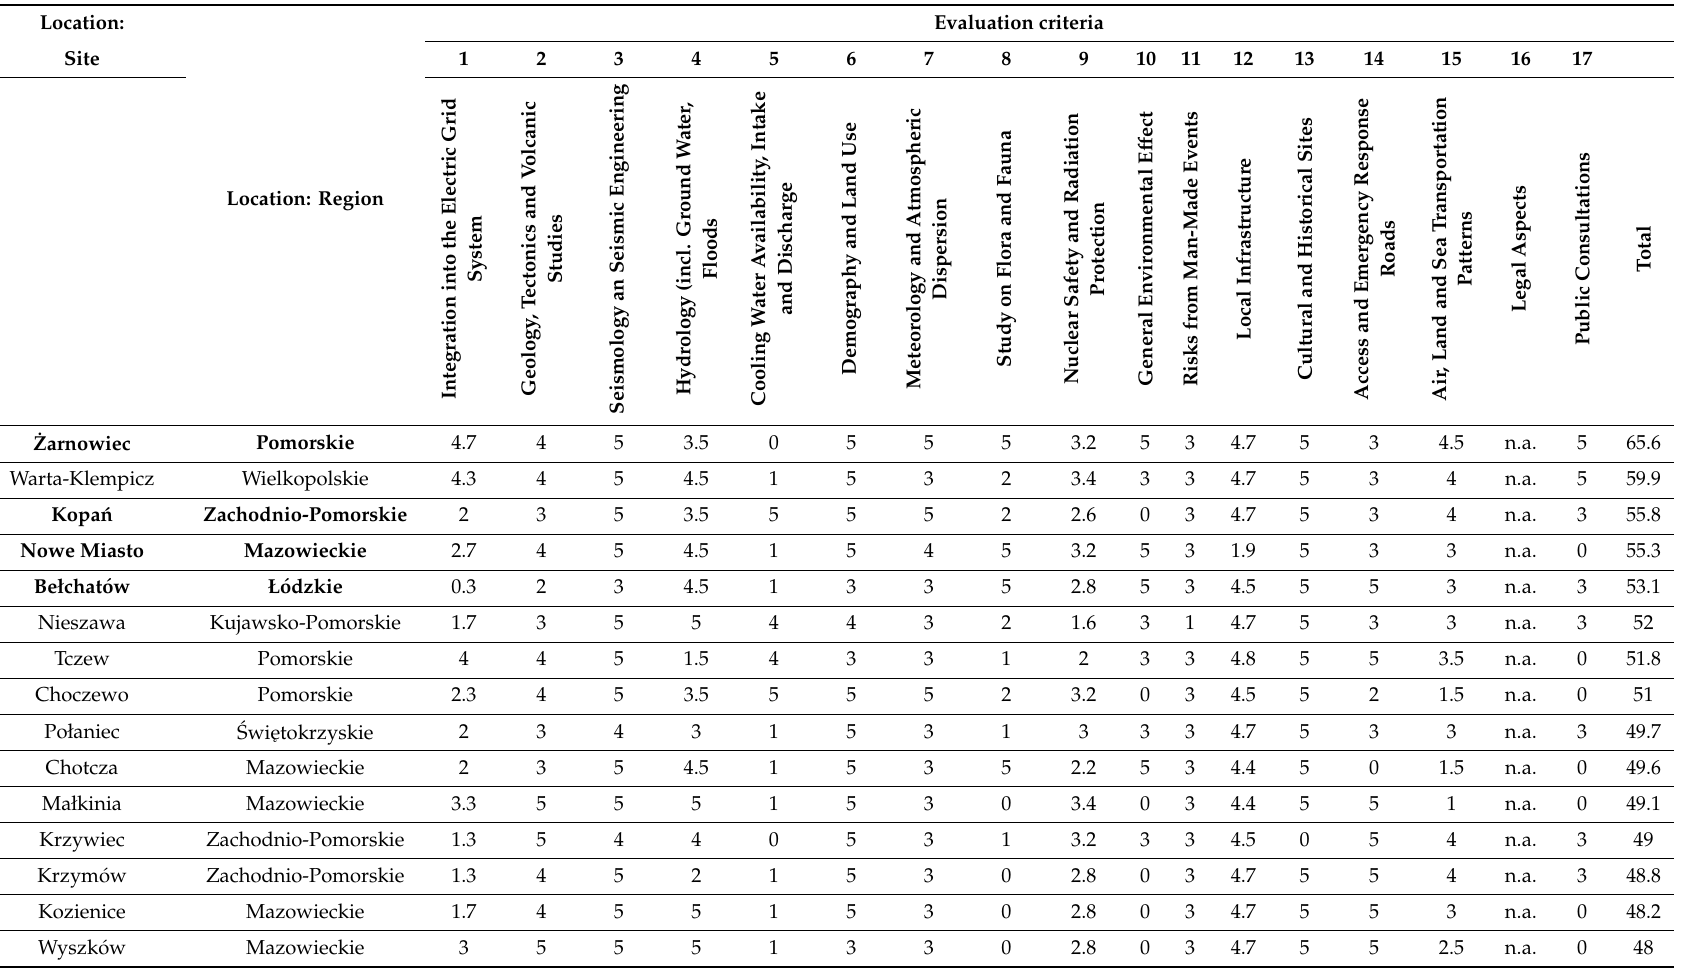
Table A1. Expert assessment of selected locations of nuclear power plants in Poland (scores in